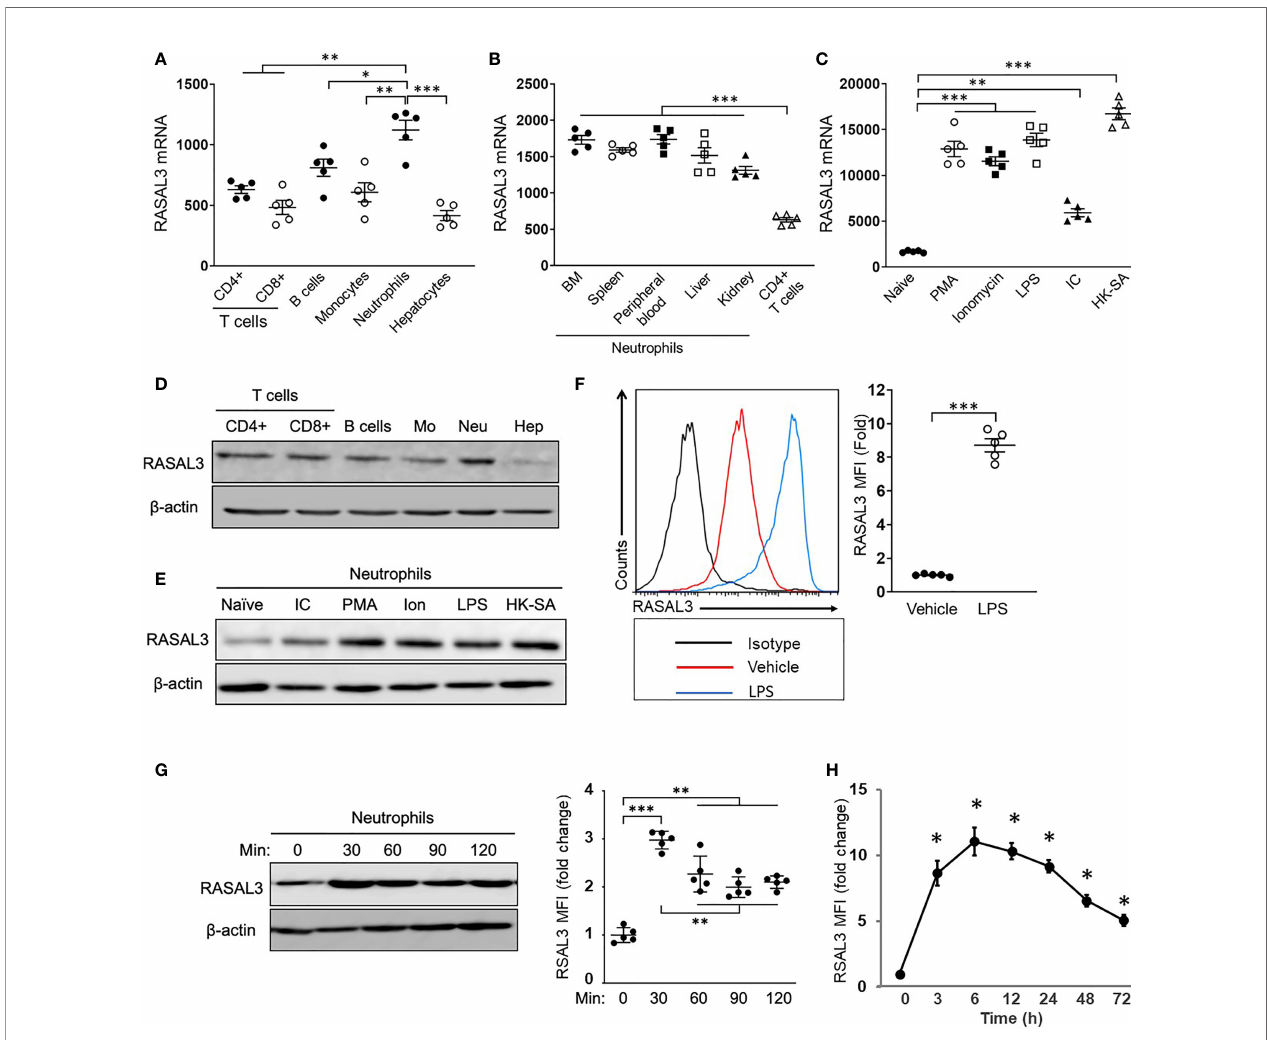
FIGURE 1 | RASAL3 is dominantly expressed in neutrophils and is upregulated by cellular activation. (A, B) The characterization of RASAL3 mRNA expression (relative to GAPDH). Total RNA was isolated from each cell population, and RASAL3 mRNA expression was measured by real-time PCR. Basal expression level of RASAL3 mRNA in splenic T cells (CD4+ T, CD8+ T), bone marrow (BM) monocytes, BM neutrophils and hepatocytes (A) , (B) A comparison of RASAL3 mRNA expression in neutrophils isolated from different tissues (from BM, spleen, peripheral blood, live, kidney). Splenic CD4+ T cells were used as control. (C) RASAL3 mRNA expression in stimulated neutrophils. BM neutrophils were stimulated with indicated agonists at 37°C for 3 h: PMA (500 ng/mL), Ionomycin (1 µg/mL), Lipopolysaccharide (LPS) (1 µg/mL), polyinosinic-polycytidylic acid (IC) (BSA 1 µg + anti-BSA mouse IgG 10 µg) and heat killed methicillin resistant S. aureus, strain USA400 (10 6 CFU/mL). PBS was used as vehicle control. (D) RASAL3 protein level in neutrophil populations as determined by Western blotting. Representative blots are shown from cells obtained as described in (A) . (E) RASAL3 protein expression in bone marrow isolated neutrophils at baseline (naïve) and upon stimulation with various stimuli for 3 h as described in (C) . (F) RASAL3 protein expression as determined by intracellular staining with fl ow cytometry analysis. Bone marrow puri fi ed cells were stimulated with vehicle or LPS. After 3 h, cells were harvested, washed and stained intracellularly for RASAL3 expression. Data are shown as mean fl uorescence intensity (MFI) of expression. (G, H) Time-course of RASAL3 protein expression by neutrophils after stimulation with LPS. In (G) , neutrophils were stimulated for 30, 60, 90 and 120 minutes. At indicated times, cells were collected and subjected to Western blotting. Protein expression is indicated relative to baseline (unstimulated). In (H) , WT mice were challenged in vivo (i.p) with LPS. At indicated times, peripheral blood was collected, and RASAL3 protein expression was determined by fl ow cytometry. Data are presented as fold change in MFI relative to time 0 (before stimulation). The data are shown as mean ± SEM. Each experiment was performed at least two independent times with identical results. n = 5. Each symbol represents independent measurement from one mouse. Values of * p < 0.05, ** p < 0.01 and *** p <